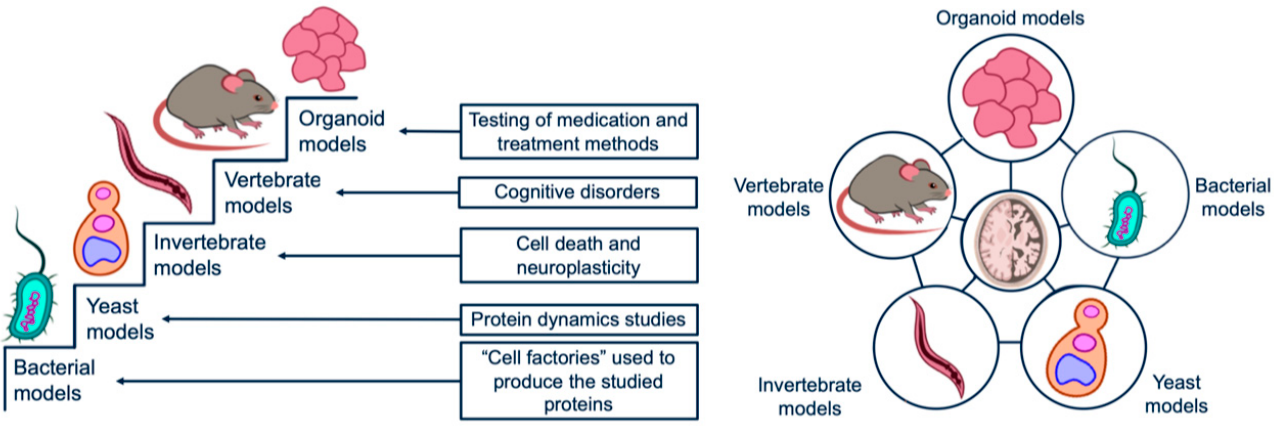
Figure 4. Two ways of a complex model systems organization. Left—‘step by step’, where each model for the study of a certain characteristic is a separate step, allowing to use of information from the previous step to study more and more complex processes gradually. The second way is a ‘network’. With this approach, studies are carried out with several types of models simultaneously, and experiments with each specific type are adjusted in conformity with the data obtained from other models.